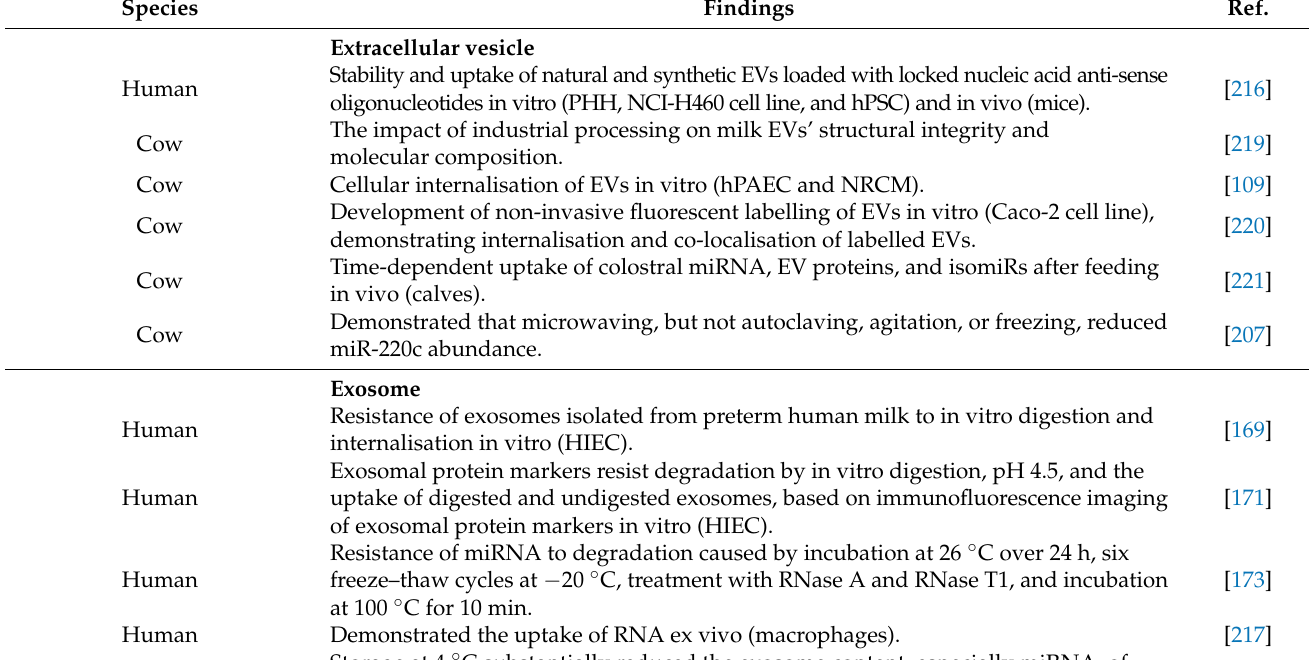
Table 6. Major findings of studies on the general stability and uptake of mammalian milk-derived EVs. Species Findings Ref. Extracellular